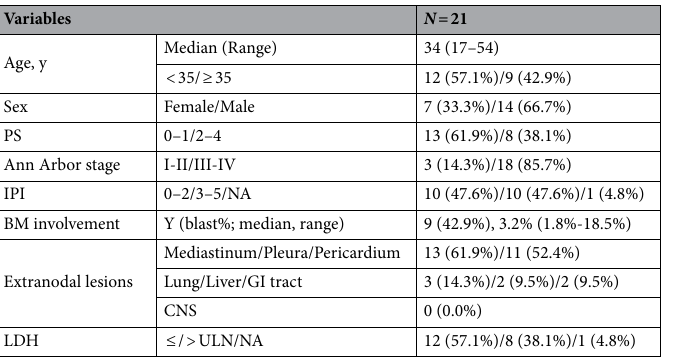
Table 1. Patient characteristics at the time of diagnosis. PS performance status, IPI international prognostic index, NA not available, BM bone marrow, GI gastrointestinal, CNS central nervous system, LDH lactate dehydrogenase, ULN upper limit of normal.